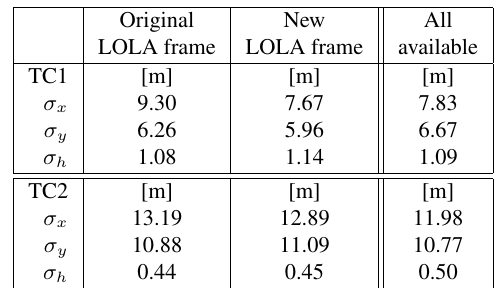
From the residuals (Figures 4 and 5) we determined the standard deviation for each LOLA frame. Additionally we also determined the standard deviation when using all available LOLA tracks in that area (see Table 2).